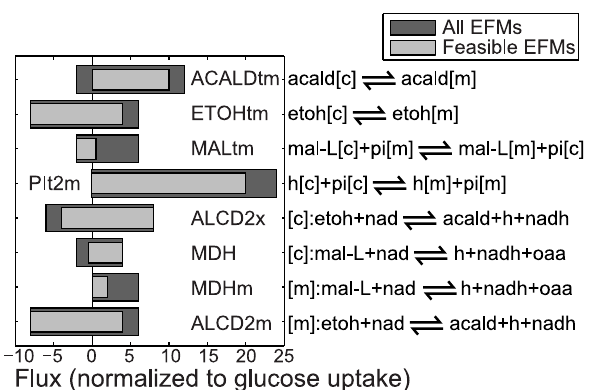
Figure 4. Ranges of possible flux values for eight reactions for which a reduction in the feasible flux range was found, during growth on glucose. The dark shaded bars show the possible flux range obtained from all EFMs, while the light shaded bars show the ranges that are obtained from the feasible EFMs. In the reaction formulas the [c] and [m] indicate that the metabolite or overall reaction occur in the cytosol or mitochondrion, respectively. Abbreviations: acald (acetaldehyde), etoh (ethanol), mal-L (malic acid), pi (phosphate), h (proton), nad ( NAD z ), nadh (NADH), oaa (oxaloacetic acid).